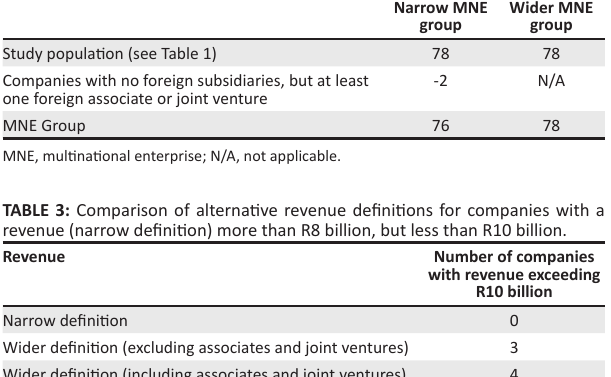
TABLE 2: Multinational enterprise group categorisation – narrow versus wider multinational enterprise group definition.